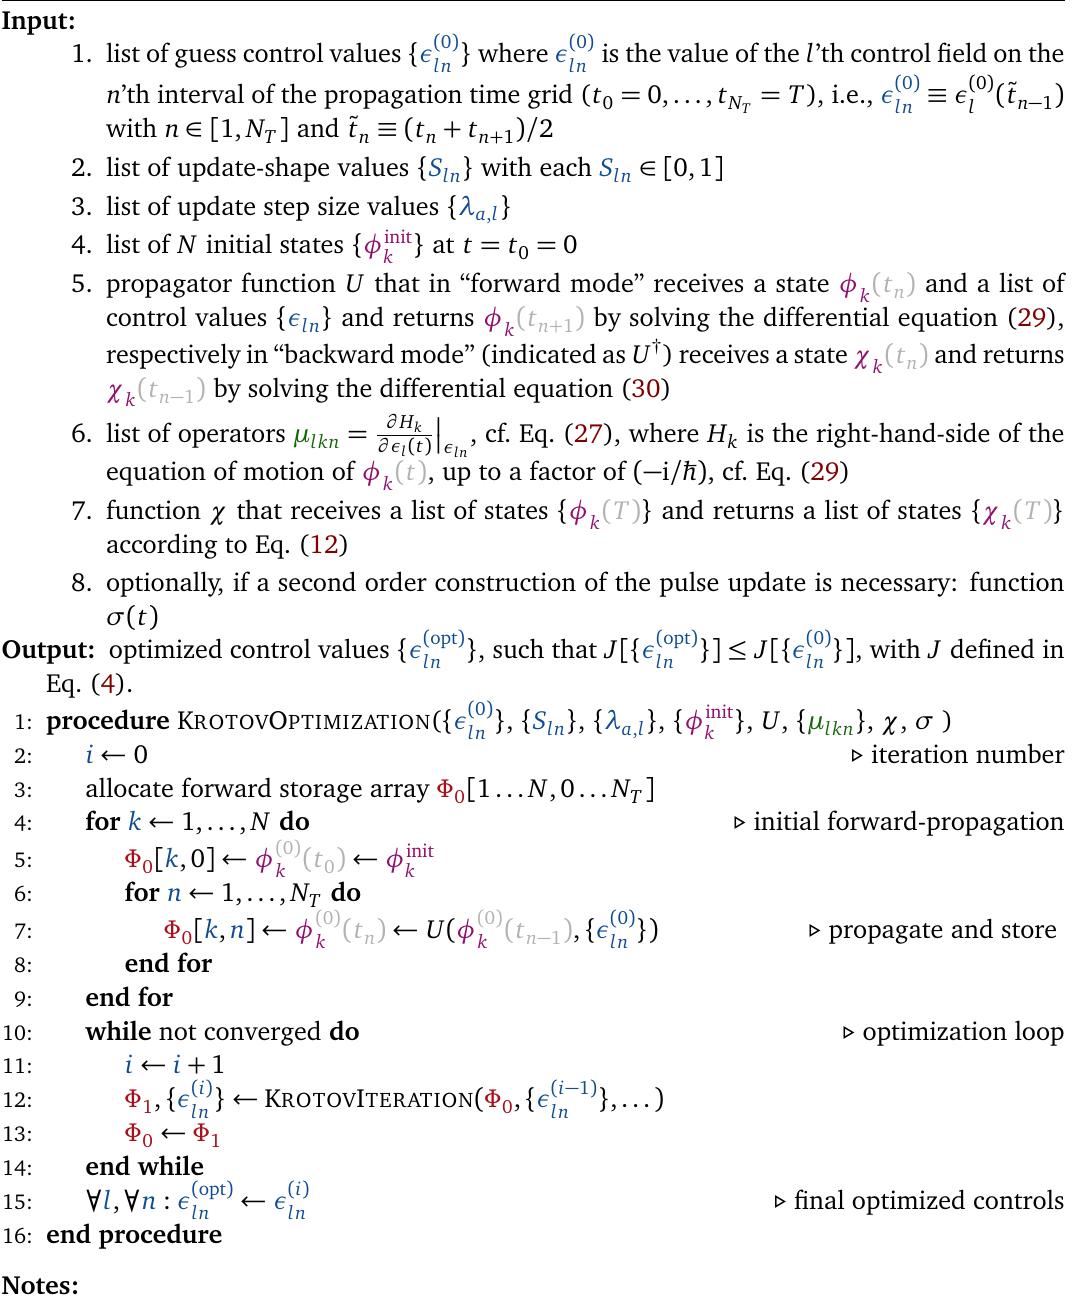
Algorithm 1 K ROTOV ’ S M ETHOD FOR Q UANTUM O PTIMAL C